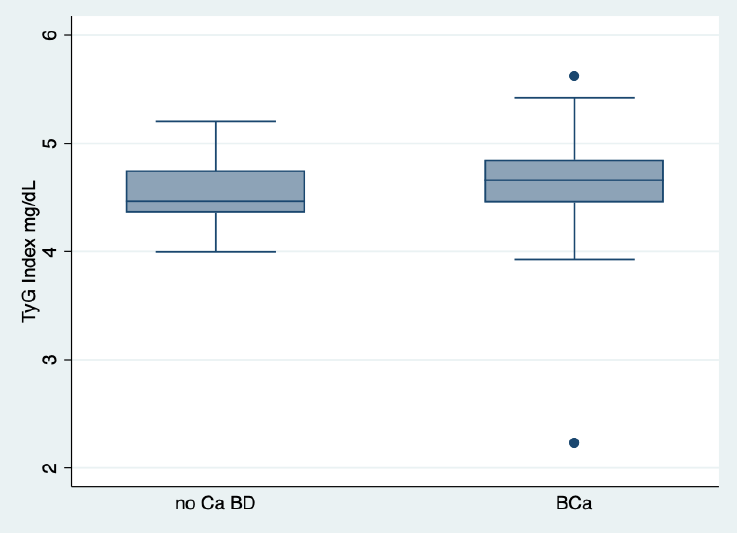
Figure 1. Behaviour of the TyG Index in both groups. TyG Index, triglycerides/glucose index; BCa, bladder cancer; no Ca BD, no cancerous bladder diseases/urinary conditions. There are two outliers among BCa group.